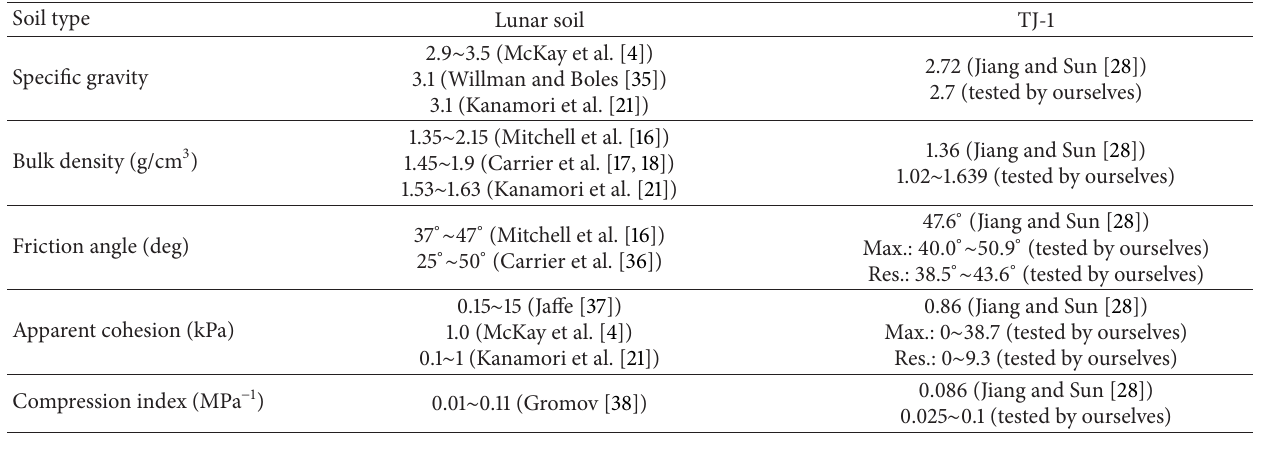
Table 1: Comparison of properties between lunar soil and TJ-1.